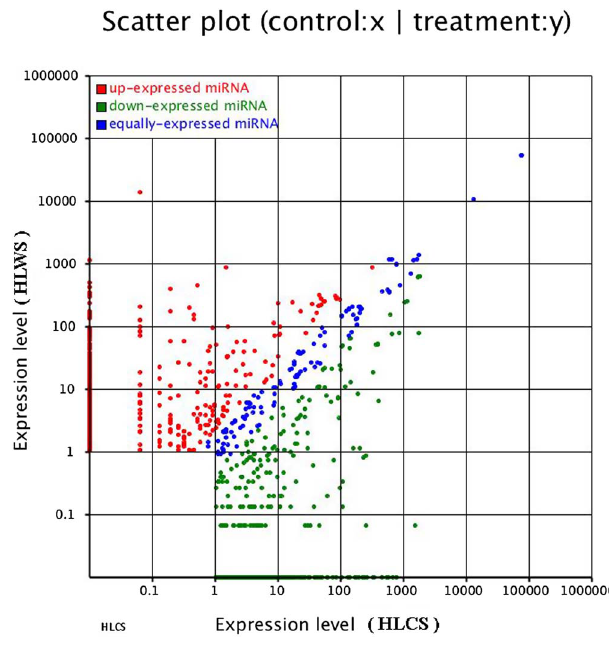
Figure 2. Comparison of differential expression levels of known miRNAs in HLWS and HLCS. Each point in the fi gure represents an miRNA. The X -axis and Y -axis show the expression levels of miRNAs in the two samples, respectively. The red points represent miRNAs with a ratio > 2. The blue points represent miRNAs with ø < ratio (cid:3) 2. The green points represent miRNAs with a ratio (cid:3) 1/2. Ratio = normalized expression in treatment groups/normalized expression in controls.